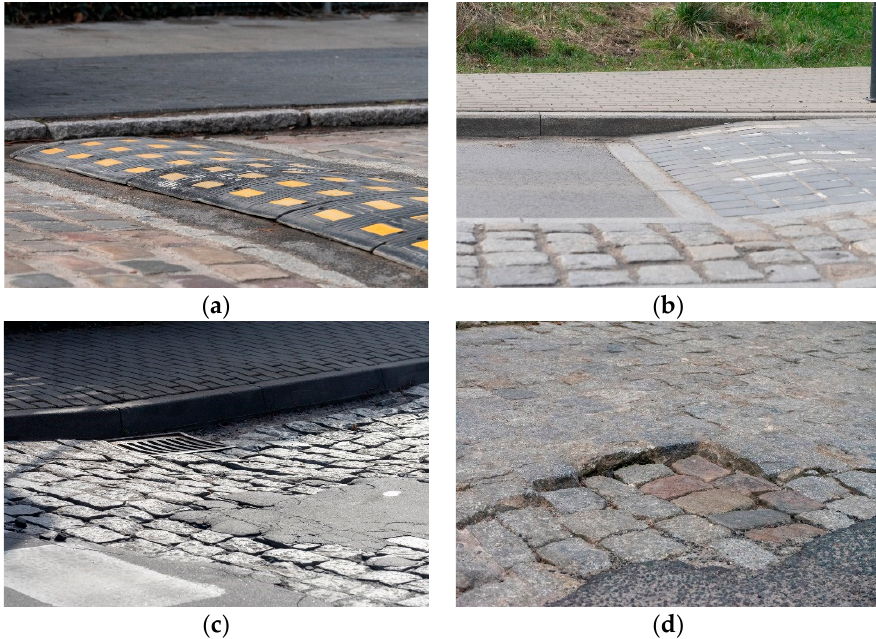
Figure 1. Main types of traffic slow-down devices ( a , b ) and examples of roadway failures ( c , d ). An exemplary course of the components of vibrations of a delivery truck, recorded with the use of accelerometers located in the cargo space, is shown in (Figure 2).